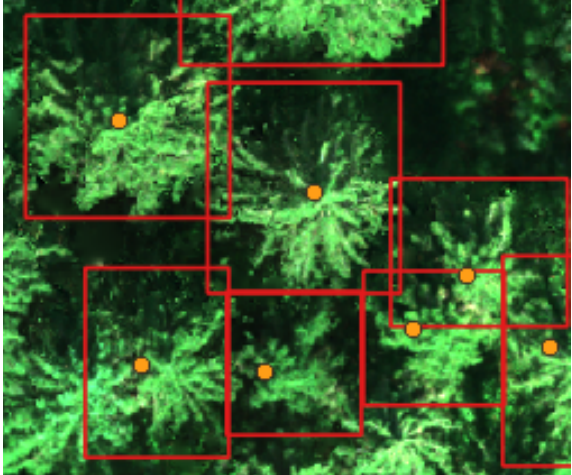
Figure 2. Example of a TDOP with labeled bounding boxes colored in red and the corresponding tree positions as points colored in